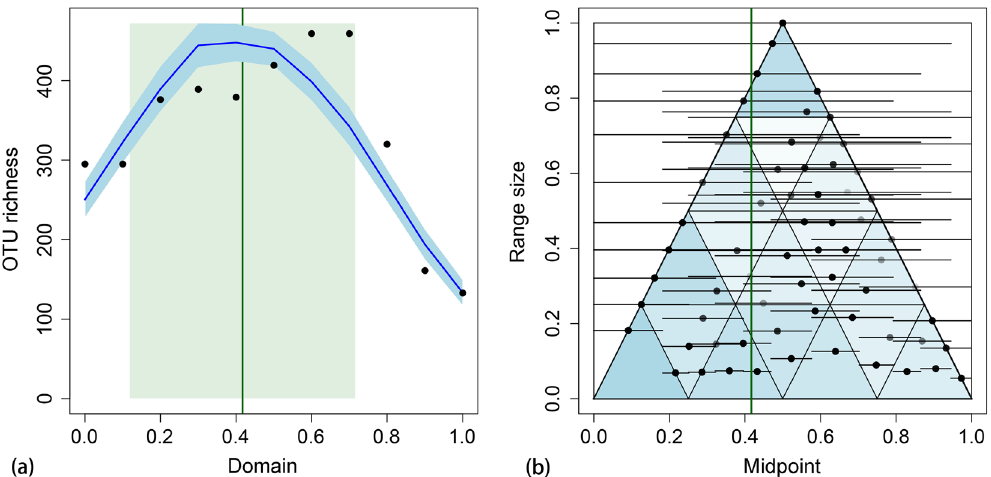
Figure 5. The Bayesian midpoint attractor model applied to the soil nematode data set rescaled to [0, 1] unit line, where 0 represents sea level. ( a ) Mean species richness (dark blue line) and 95% confidence interval (light blue band) for 200 simulations. Dark green vertical line, midpoint attractor; light green rectangle, standard deviation; blue line, modelled OTU richness; black dots, empirical OTU richness. ( b ) Midpoint-range plot for the same data. The x-axis is the location of the range midpoint for each OTU on the elevational domain, and the y-axis plots the elevational span of the range (range size). The large triangle sets the geometrically feasible midpoint limits for ranges of a give size. Black and grey points and associated horizontal line segments illustrate the empirical midpoint and range values for the 1,121 OTUs of soil nematodes. Because many OTUs have identical ranges and midpoints in the data set, the shading of each point is proportional to the number of coincident OTU midpoints. The white-to-blue color scale in the 16 small triangles is proportional to the mean number of modelled points falling in each triangle, averaged over the 200 runs of the